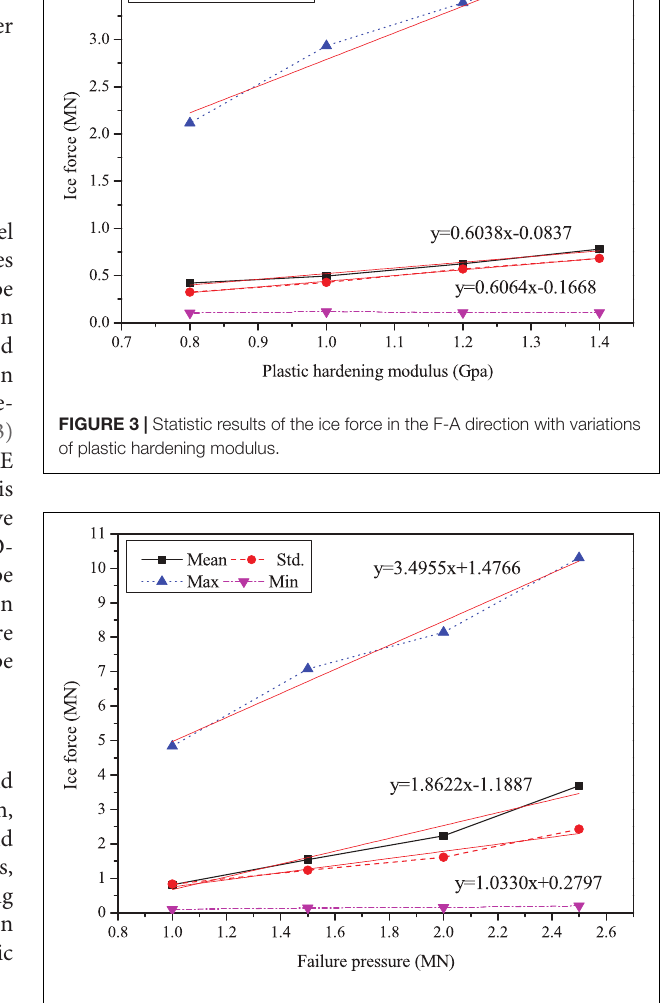
FIGURE 4 | Statistic results of the ice force in the F-A direction with variations of failure